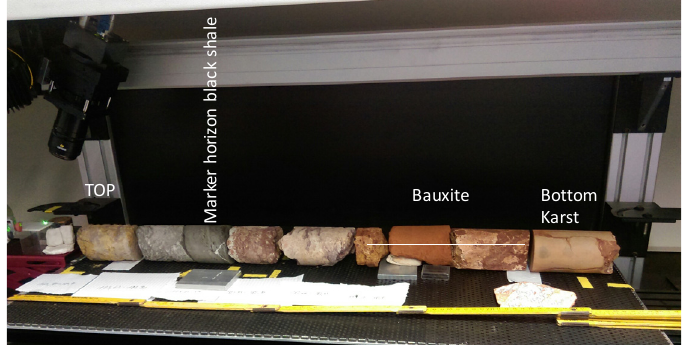
Figure 1. LIBS measurement configuration of composite bauxite profile.